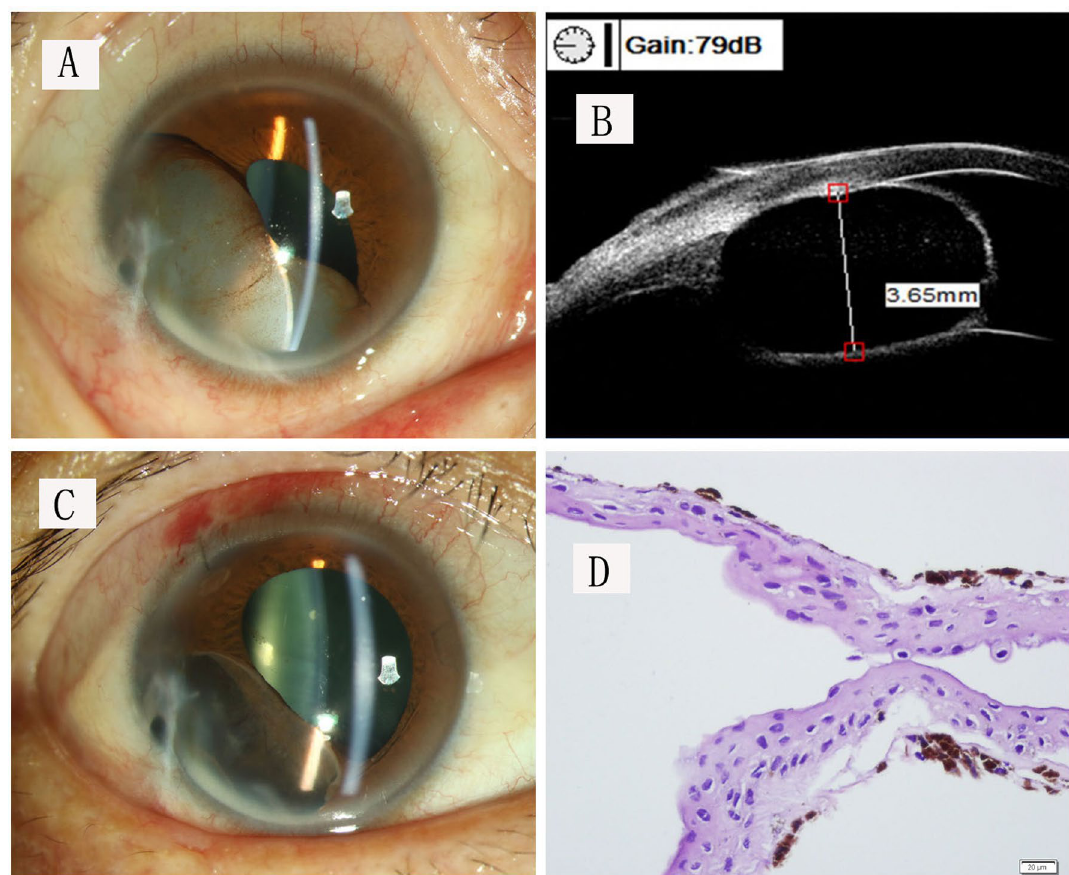
Figure 2. Treatment outcomes of this “open iridectomy” technique. ( A ) An iris cyst covered part of the pupil in the anterior chamber. ( B ) The UBM image showed the cyst attached to the anterior chamber angle and corneal endothelium. ( C ) The iris stroma and the pupil were preserved after the cyst wall was removed. ( D ) Pathological examination illustrated a non-keratinised stratified squamous epithelium (hematoxylin–eosin staining; bar = 20 microns).